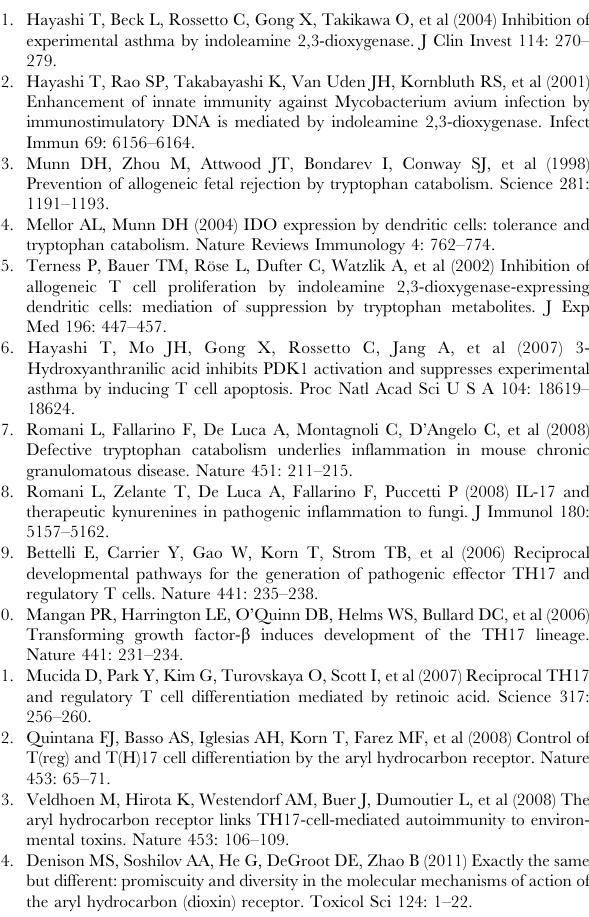
Figure S8 Dose-response effect of CA on IL-22 produc- tion from human CD4 + T cells in total naı¨ve cell cultures. Flow cytometric analysis of cord blood naı¨ve CD4 + T cells stimulated under polarizing conditions (as in Figure S7) with DMSO or CA (0.5, 1, 5, or 10 m M). Frequency of IL22 + CD4 + T cells relative to total events from four experiments was analyzed by repeated measures one-way ANOVA and Dunnett’s Multiple Comparisons Test. *, p ,